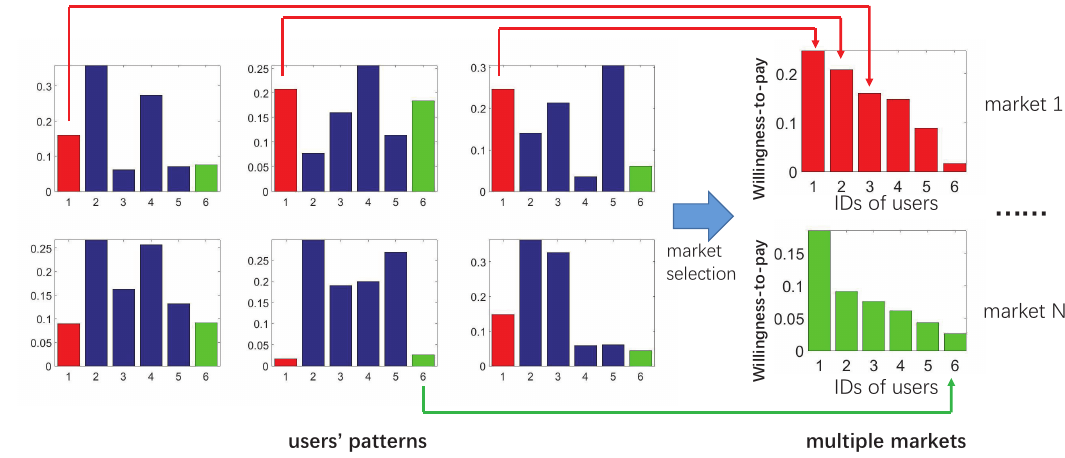
Figure 3. The emergence of markets based on users’ patterns. Preferences in one specific category from each user establish one market, indicated by